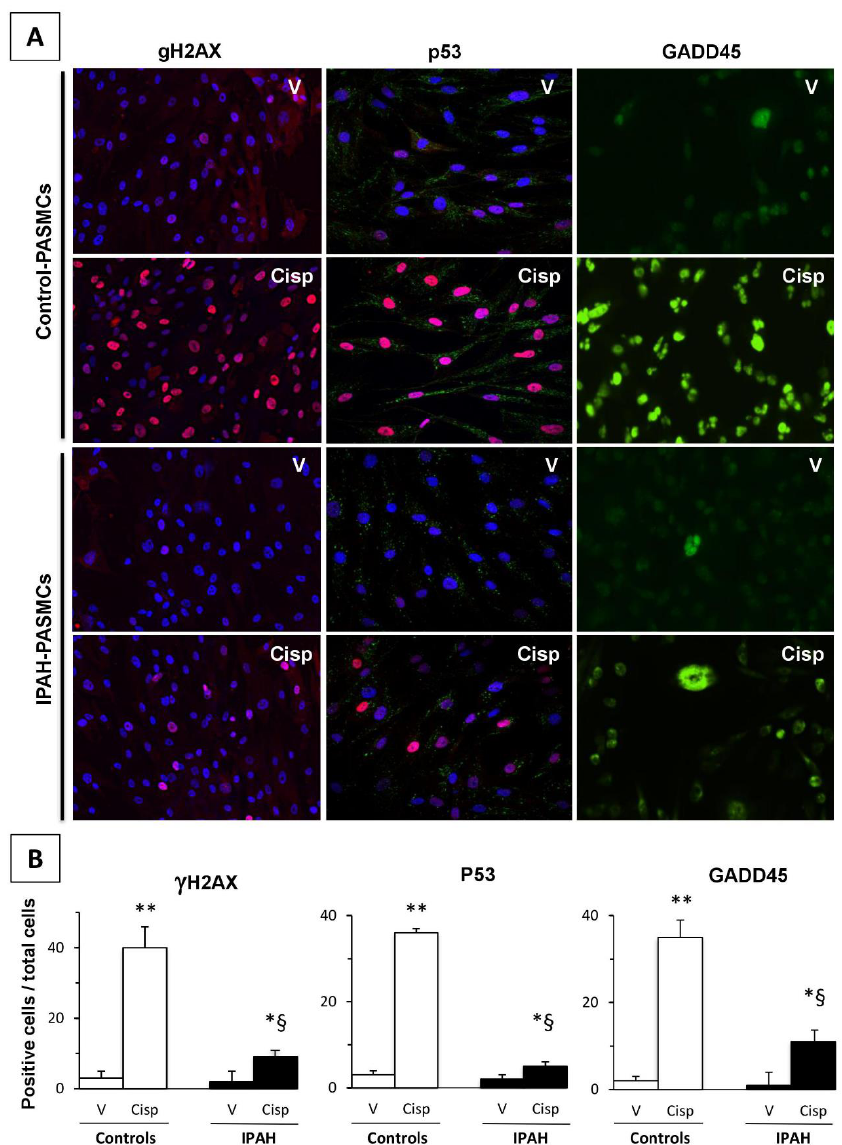
201 Figure 6. DNA damage and repair in IPAH. ( A ) Representative fluorescence microscopy images of phosphorylated γ H2AX, p53, and GADD45—factors required for cell cycle arrest. Stimulation with cisplatin caused a sharp increase in γ H2AX phosphorylation, which was higher in controls than in IPAH samples. Phospho-p53 and - growth arrest and DNA damage-inducible (GADD)45 staining patterns also showed similar profiles. ( B ) The ratio of positive cells / total cells in each condition was quantified in PASMCs ( n = 6 in each group). 100 × magnification. * p < 0.05, ** p < 0.01 between vehicle and cisplatin. § p < 0.01 between control- and IPAH-PASMCs under the same